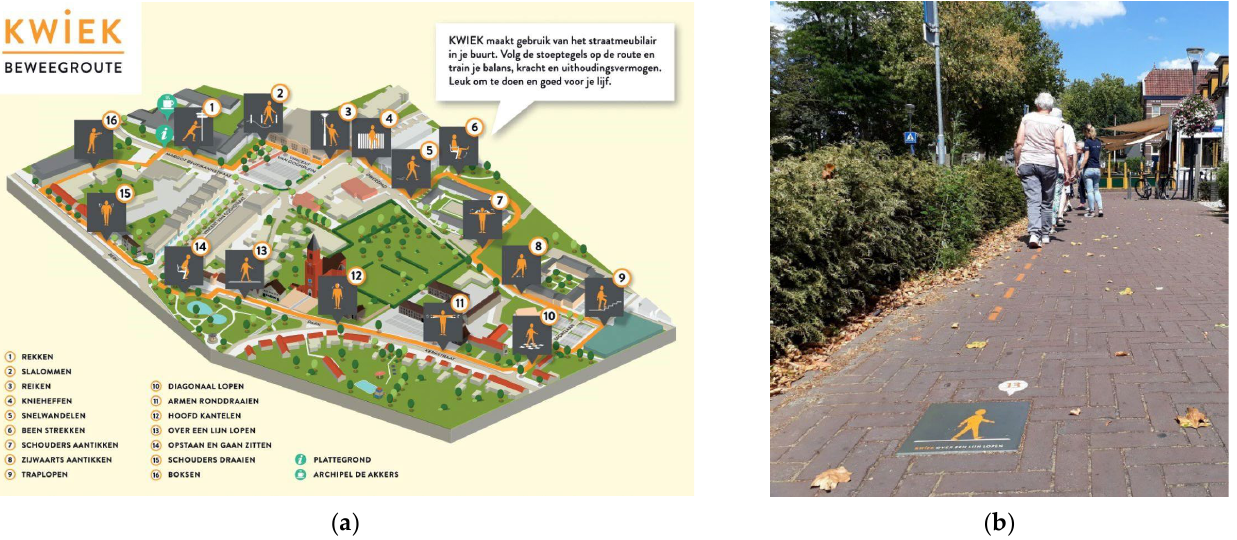
Figure 25. Outline of the Kwiek Beweegroute project. Source: Studio van Laar, Kwiek Beweegroute Nuenen. ( a ) Itinerary with the different exercises across the neighborhood, creating a continuous path for activity and socializing in the outdoor space. ( b ) Micro-elements that are integrated in tiles, urban furniture, and public spaces promote multiple activities and exercises that have been developed with training specialists, physiotherapists, and a design